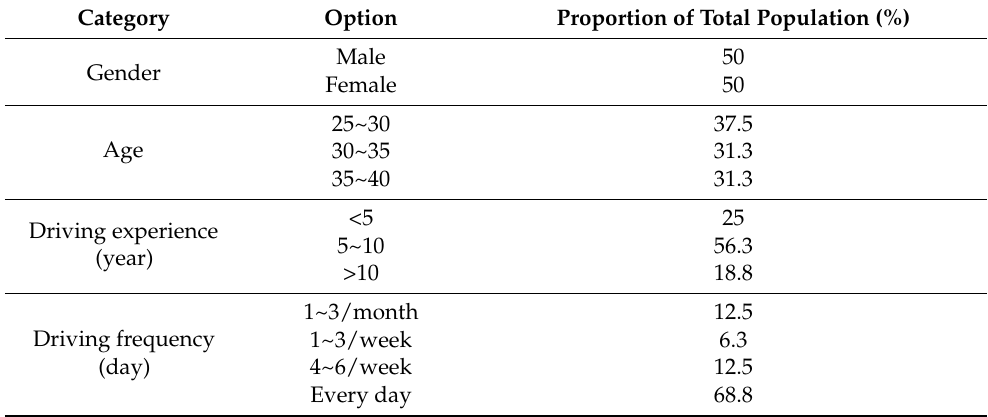
Table 1. Information of participants.